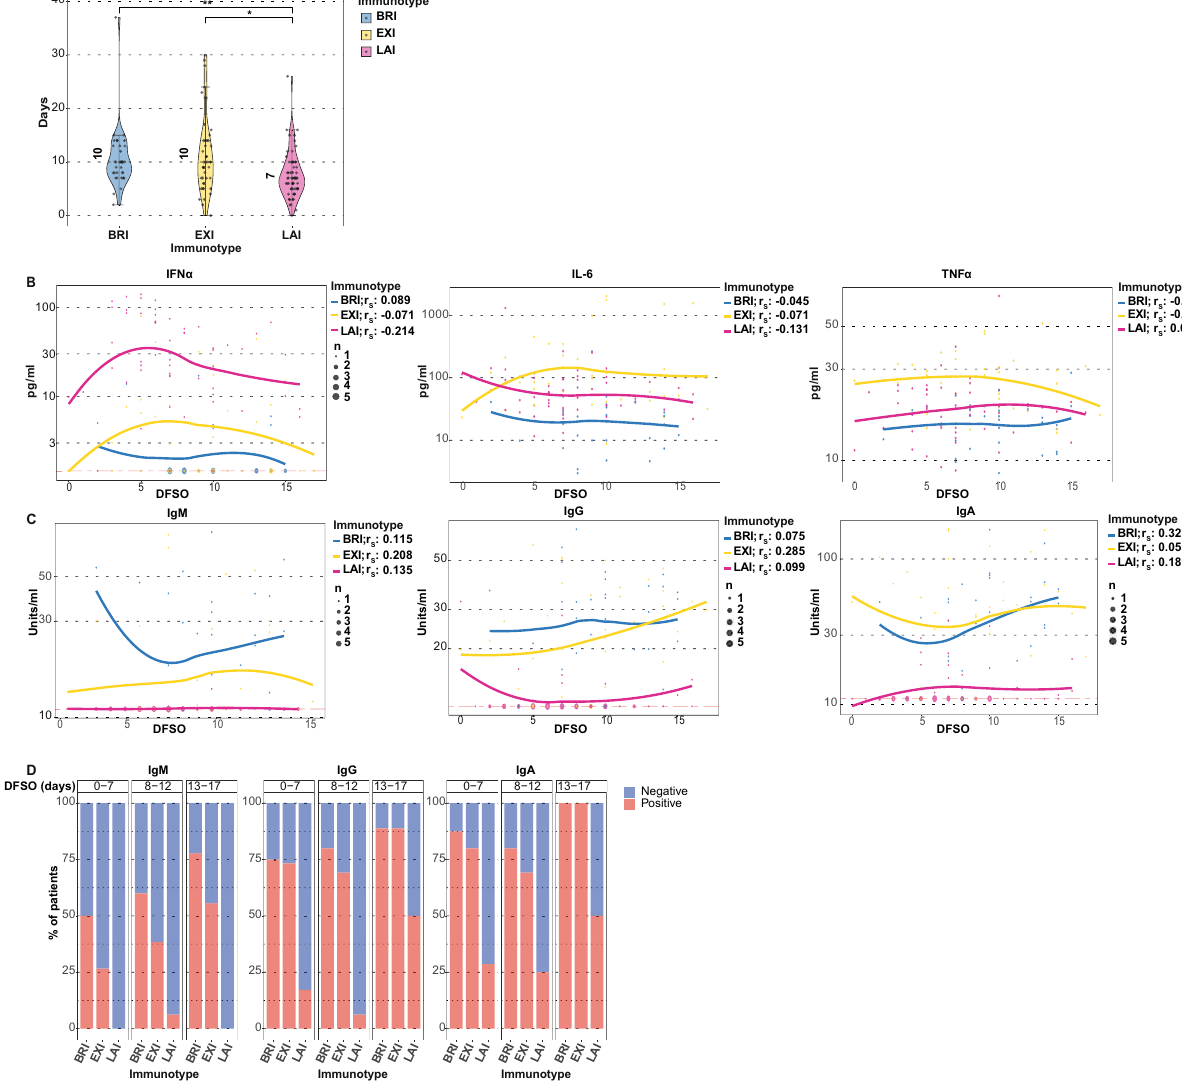
Fig. 4 Disease duration does not determine immunotypes. Cytokine differences and the absence of antibodies in LAI are not due to lesser disease duration. A Days from symptoms onset (DFSO). Medians shown by number and whiskers indicate the 1.5x IQR value. Two-sided Wilcoxon rank-sum tests with Bonferroni correction were applied. * p < 0.05, ** p < 0.01. B Scatterplots of IFN α , IL-6, and TNF α with DFSO per immunotype shown. C Scatterplots of anti-SARS-CoV-2 antibodies with DFSO is shown per immunotype. For B and C , Spearman ’ s rho is shown per immunotype and Bonferroni adjusted p -value is added when signi fi cant. Non-parametric local polynomial regression lines plotted using the locally estimated scatterplot smoothing (LOESS) method are shown for individual immunotypes. D The percentage of antibody positivity for the three immunotypes is depicted in relation to their DFSO. Red depict percent of patients positive for antibodies, blue depicts percent negative. Data shown are from BRI ( n = 33), EXI ( n = 46), and LAI ( n = 59)